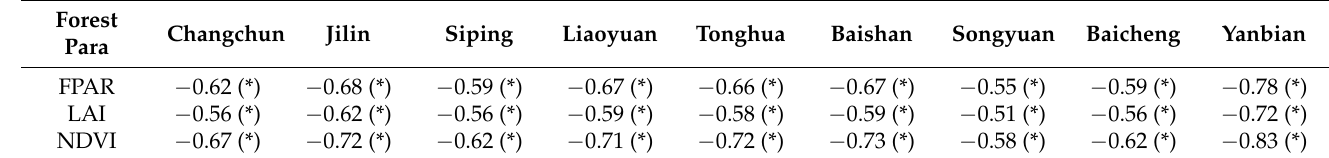
Table 8. Relationship between SO 2 concentration and vegetation characteristic in different seasons from 2015–2020.